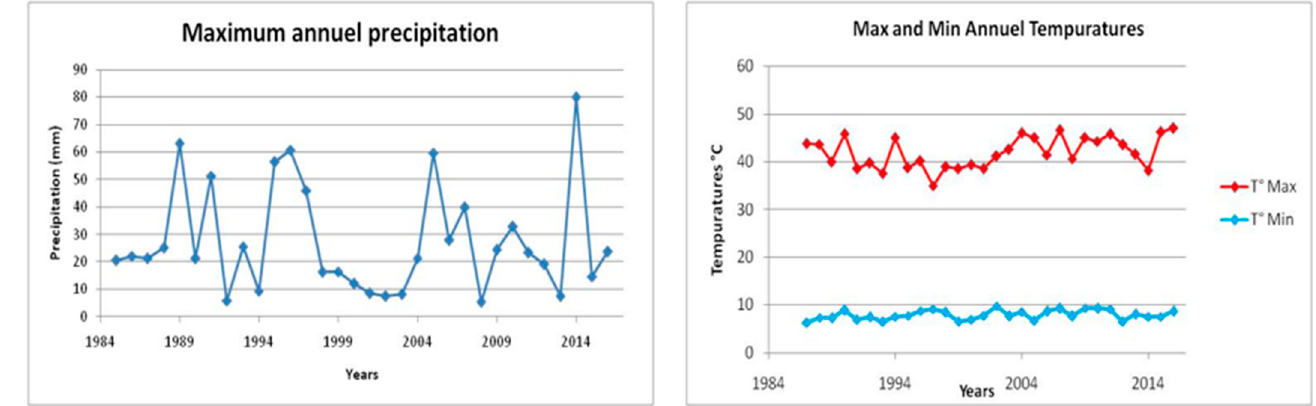
Figure 3. Data on precipitation and temperature recorded in the research area from 1984 to 2016.